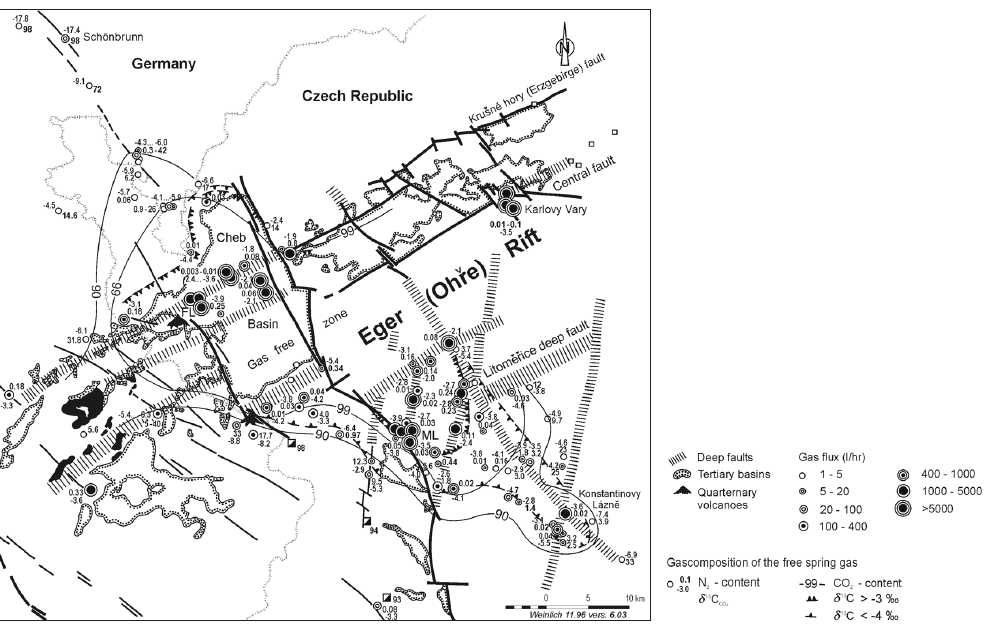
Fig. 1. Distribution pattern of gas flux (free gas), gas composition (air-free) and δ 13 C CO springs and mofettes in the western Eger Rift, Czech Republic (data taken from Weinlich et al ., 1998, 1999, 2003). Legend: ML – Mariánské Lázneˇ; FL – Frantisˇkovy Lázneˇ; half-filled squares – uranium mines with gas blowouts.